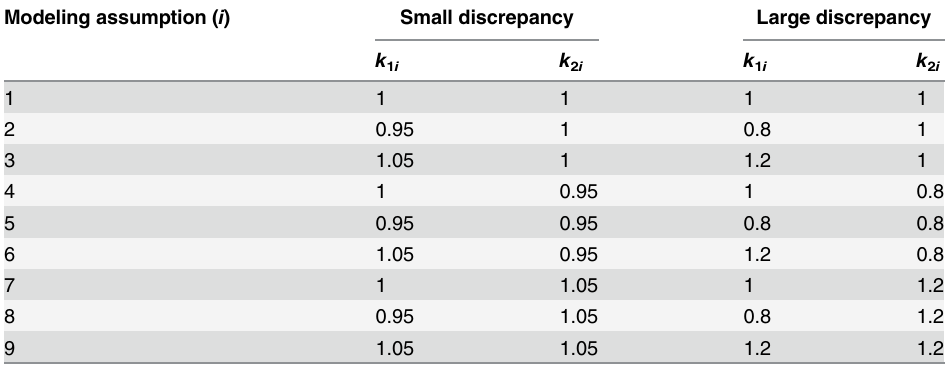
Table 1. Scaling constants k1 i and k2 i used for each modeling assumption i in the small and large dis- crepancy ensemble. Modeling assumption ( i